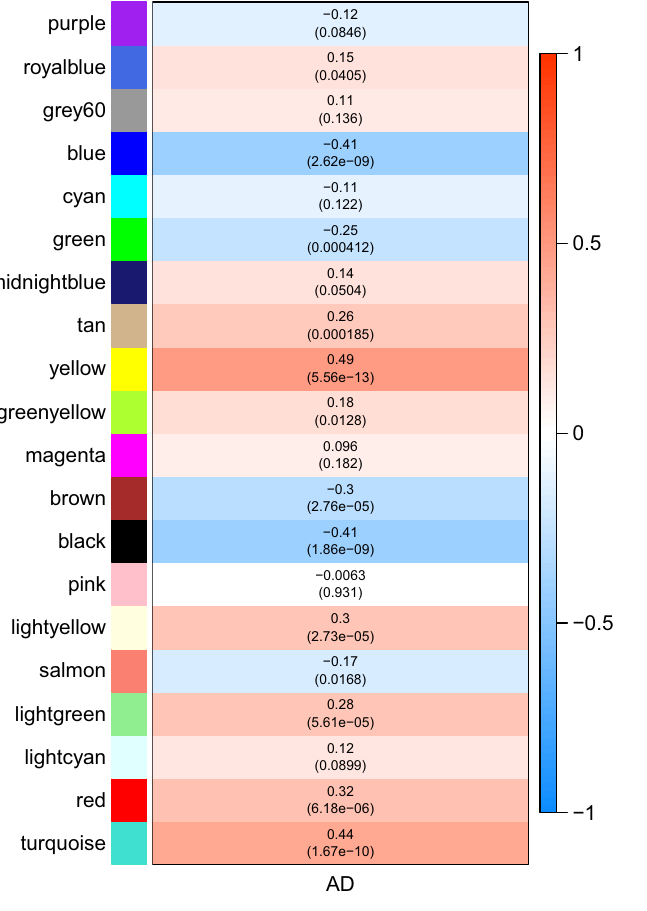
Figure 7. Module-disease